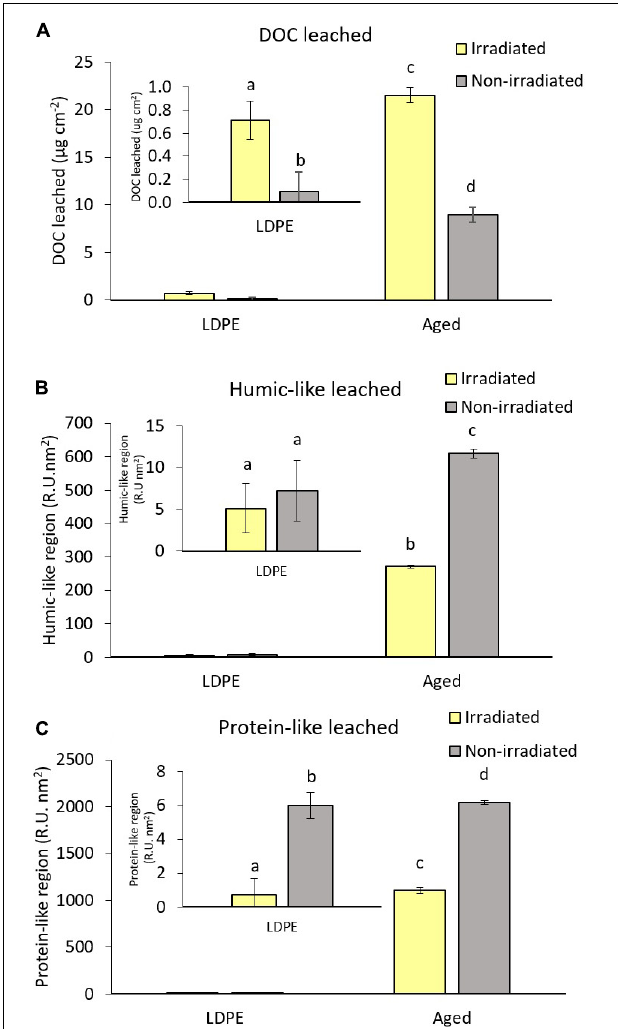
FIGURE 1 | Dissolved organic matter leached from LDPE and aged plastics in the irradiated and non-irradiated treatments during the photodegradation experiment (A) dissolved organic carbon; (B) fluorescent dissolved organic matter integrated in the humic-like region; (C) fluorescent dissolved organic matter integrated in the protein-like region. An enlargement of the LDPE values during the leaching incubation is included in all panels. The same letter over different bars indicate non-significant differences between them. Error bars represent the standard deviation of the mean of the triplicate